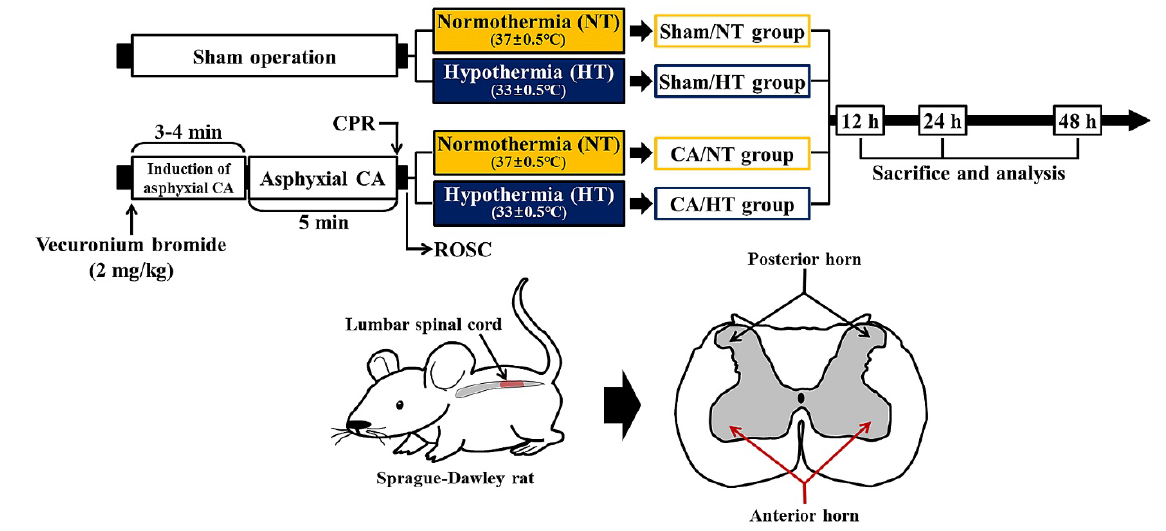
Figure 1. Experimental timeline with design. CA, CPR, and ROSC were performed at designated times. Therapeutic HT was done after ROSC for four hours. Sacrifice was done for analyses in the anterior horn of the lumbar spinal cord at 12, 24, and 48 h after